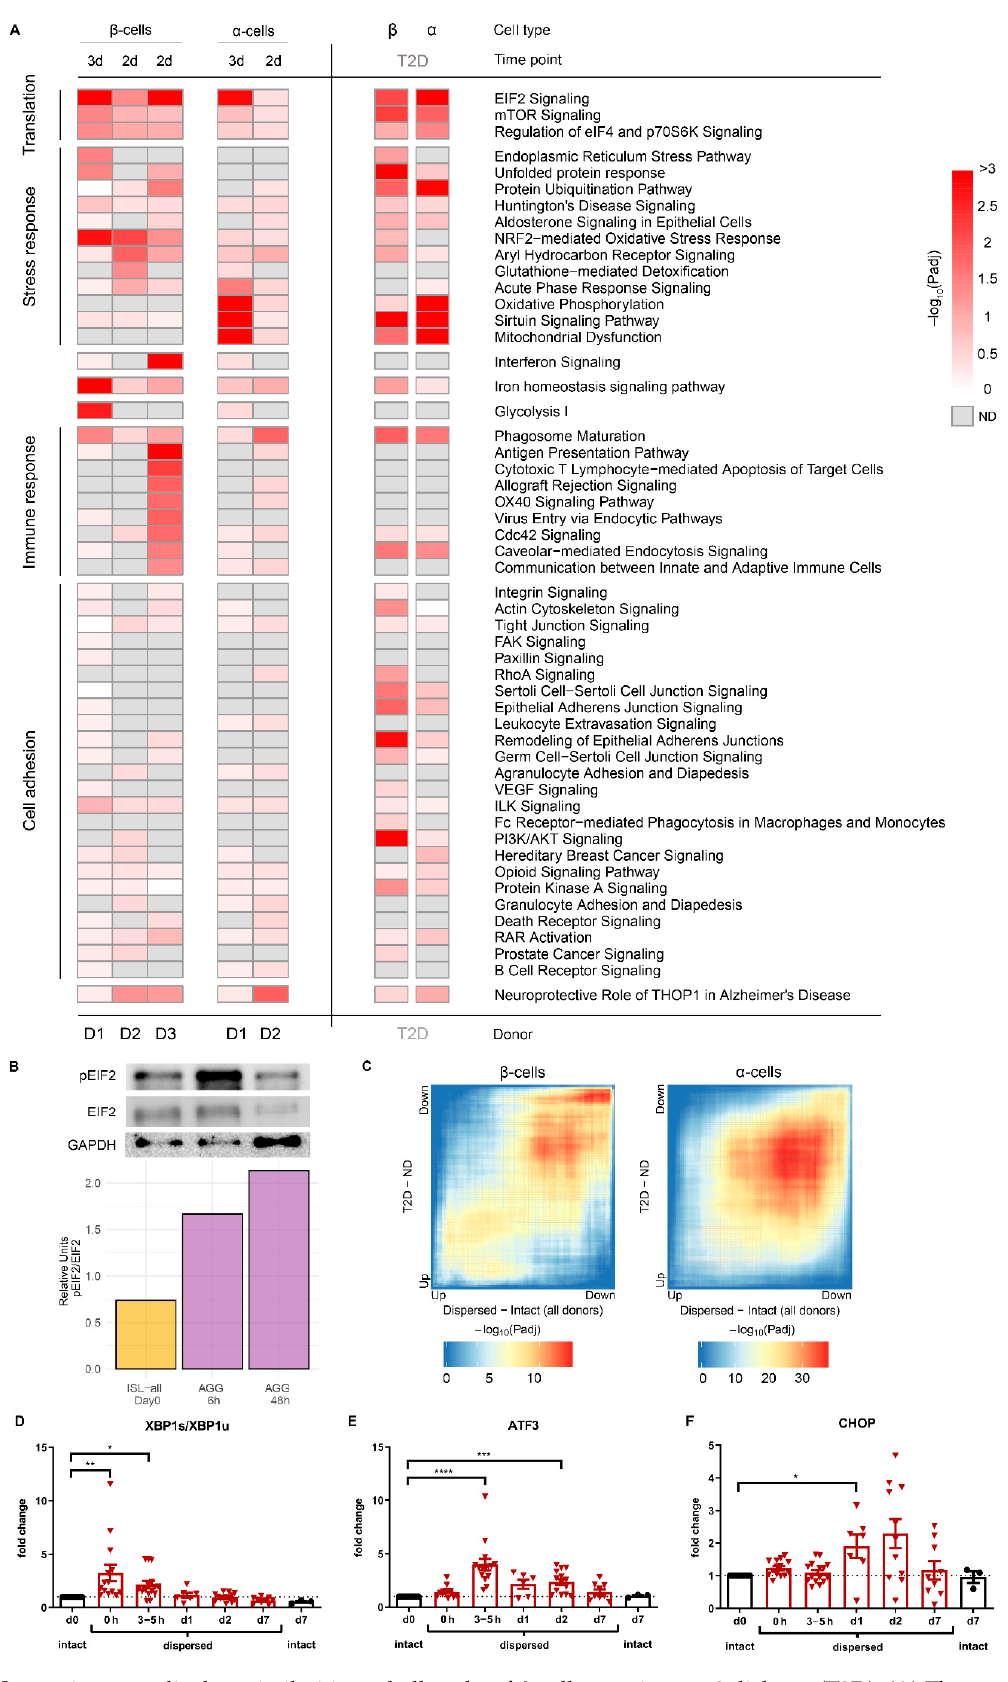
Figure 2. Stress signature displays similarities to hallmarks of β -cell stress in type 2 diabetes (T2D). ( A ) The response of β - and α -cells in the islet integrity disruption model was further characterised and compared to the transcriptional profiles